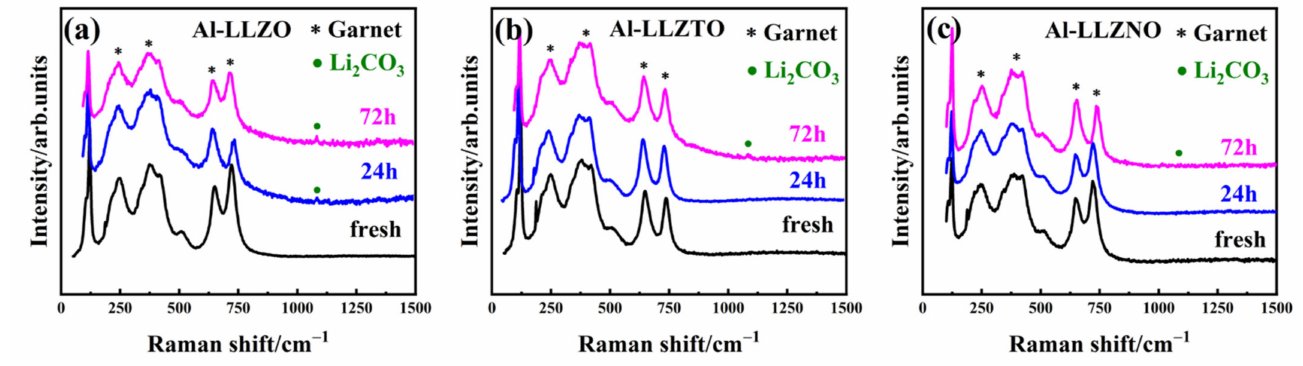
Figure 3. Raman spectra of as-prepared, 24 h air-exposed, and 72 h air-exposed ( a ) Al-LLZO, ( b ) Al-LLZTO, and ( c )